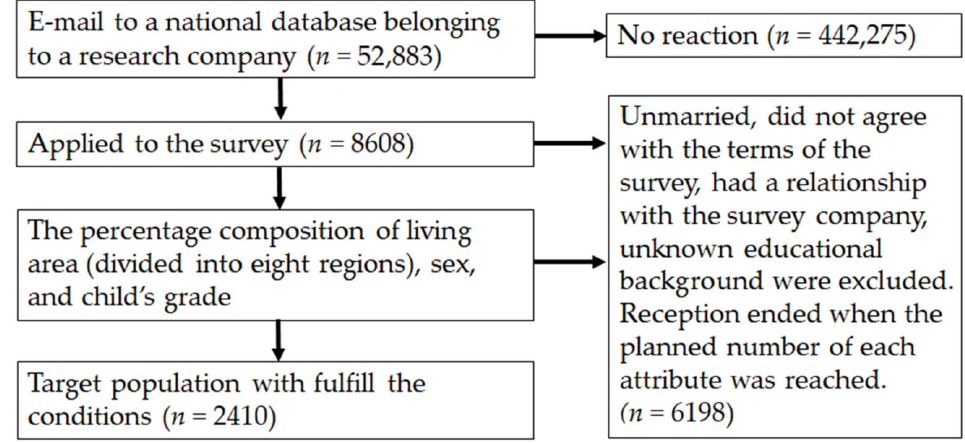
Figure 1. Participant